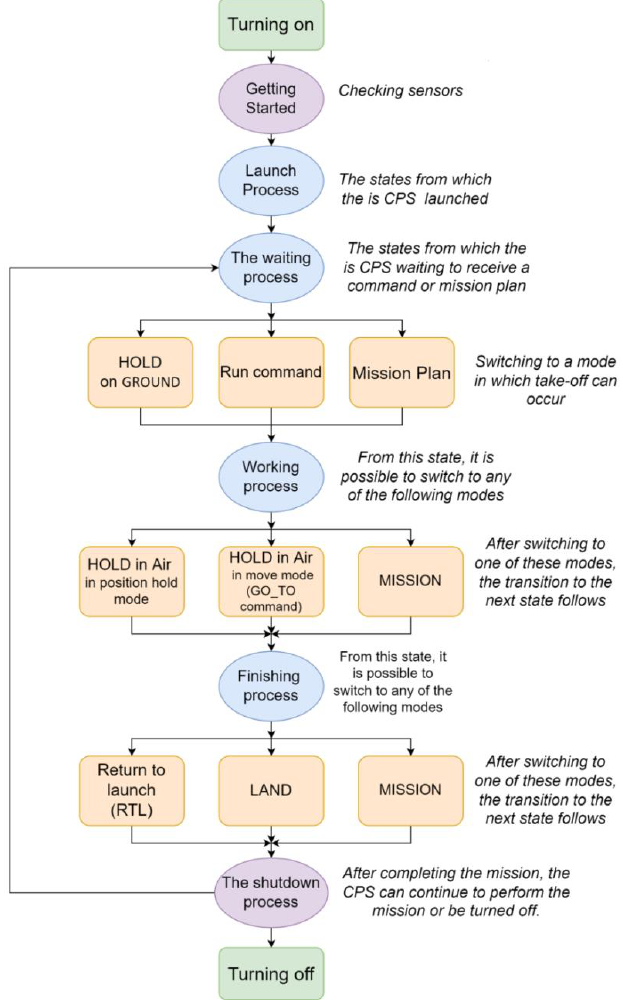
Figure 2. Scheme of possible transitions of processes through various modes of operation in the case of a UAV.